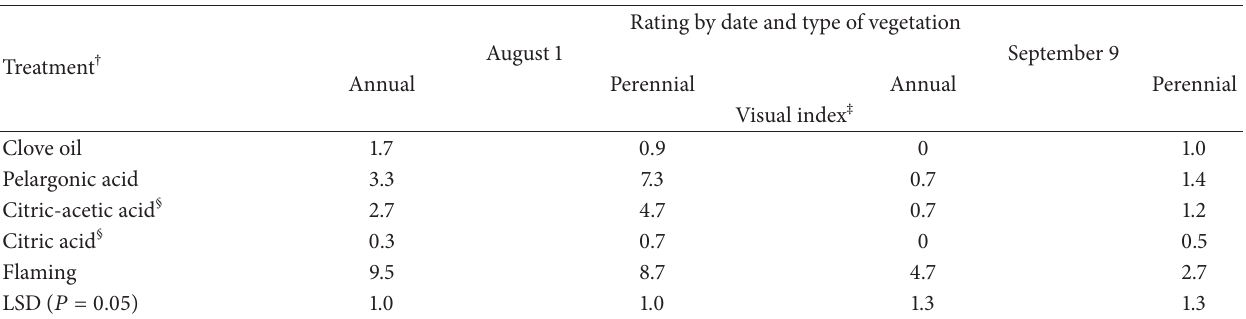
Table 7: Efficacy of alternative herbicides and burning of vegetation at ten days and six weeks after one application of treatments in field plot experiment with repeated applications on annual and perennial vegetation (Field Experiment 2).